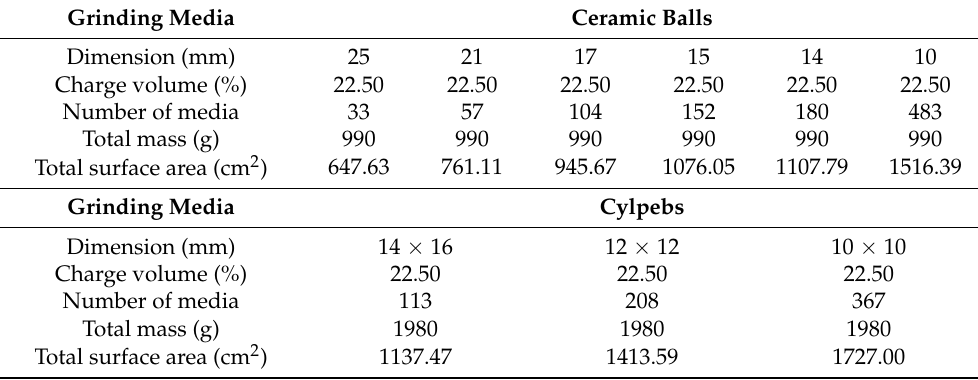
Table 4. Ceramic balls and cylpebs with the same charge volume (%).